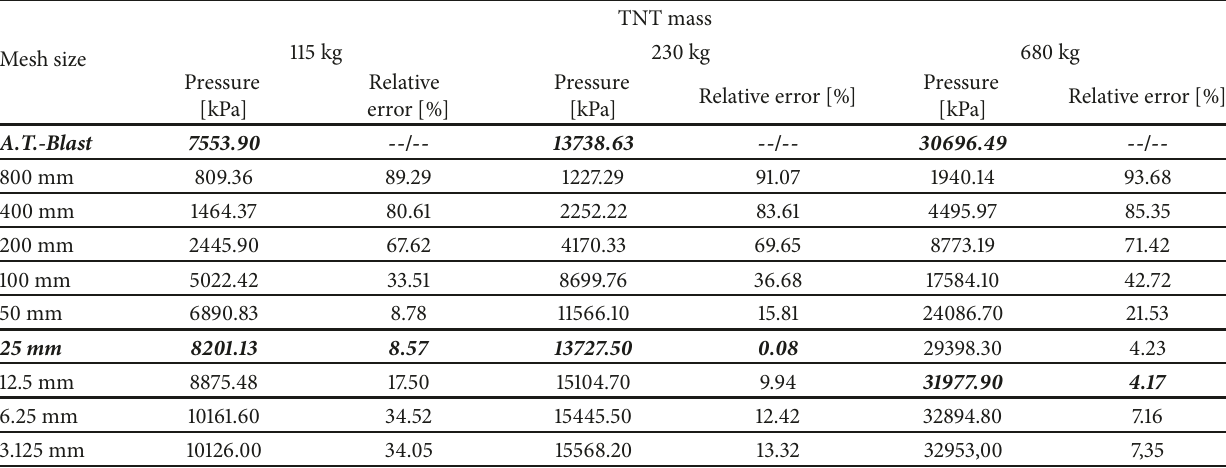
Table 8: Comparison of maximum reflected pressures in dependency of air mesh size for a gauge point at the range of 5 m.